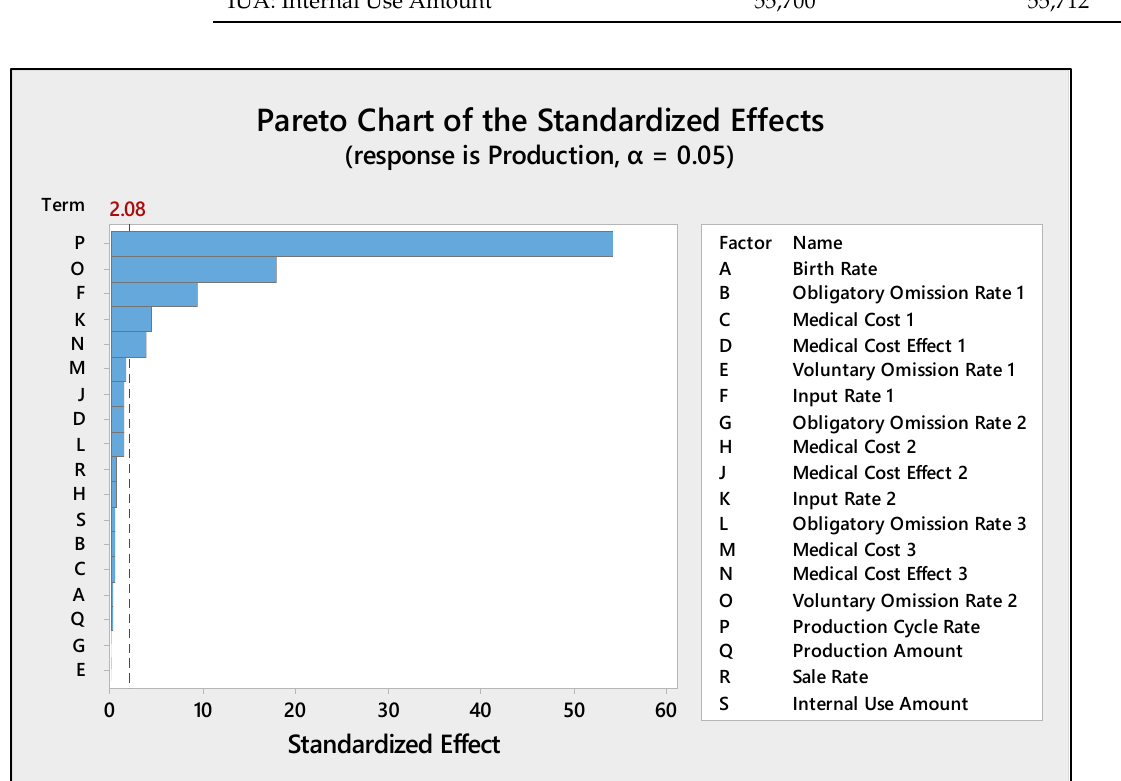
Figure 7. Normal diagram to identify the important variables in production. After the identification of important variables, three levels were considered including two high and low levels and the real rate of the important variable, and then the full tests were carried out to gain the optimal value of each variable. The route for conducting tests in software Minitab is as follows: Stat → DOE → Factorial → Create Factorial Design … → General Full Factorial Design